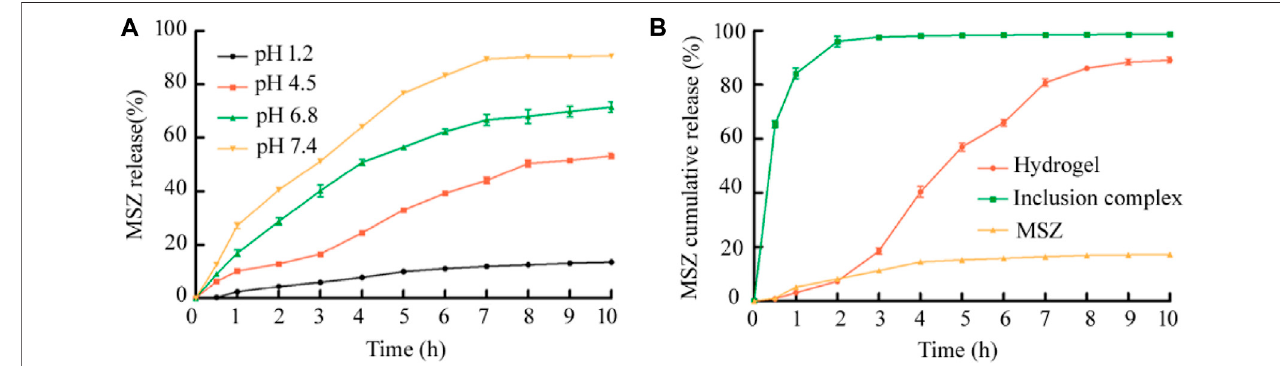
FIGURE 4 | (A) The release rate of MSZ from the Alg/Cs/Car hydrogel under different pH medium conditions was compared; (B) In vitro cumulative release of the drug-loaded hydrogel, the HP- β -CD/MSZ inclusion complex, and free MSZ under simulated in vivo conditions. Data are mean ± SD ( n (cid:2) 3) of three independent experiments.